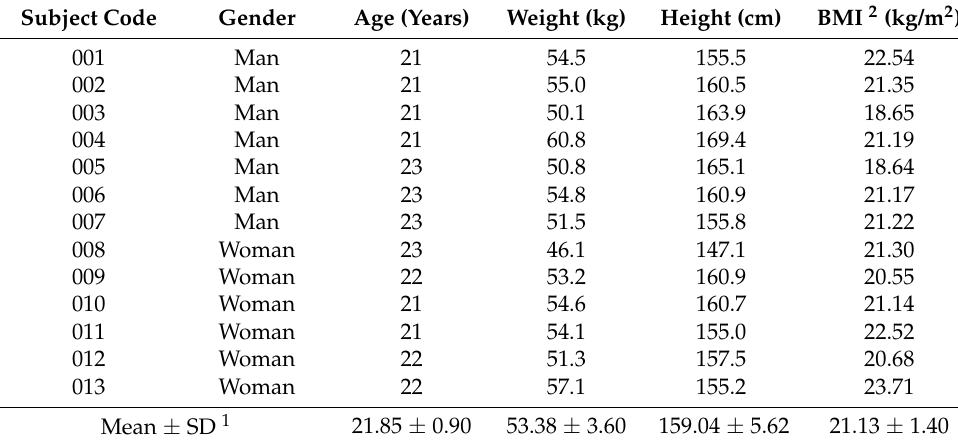
Table 2. Subject characteristics for glycemic index